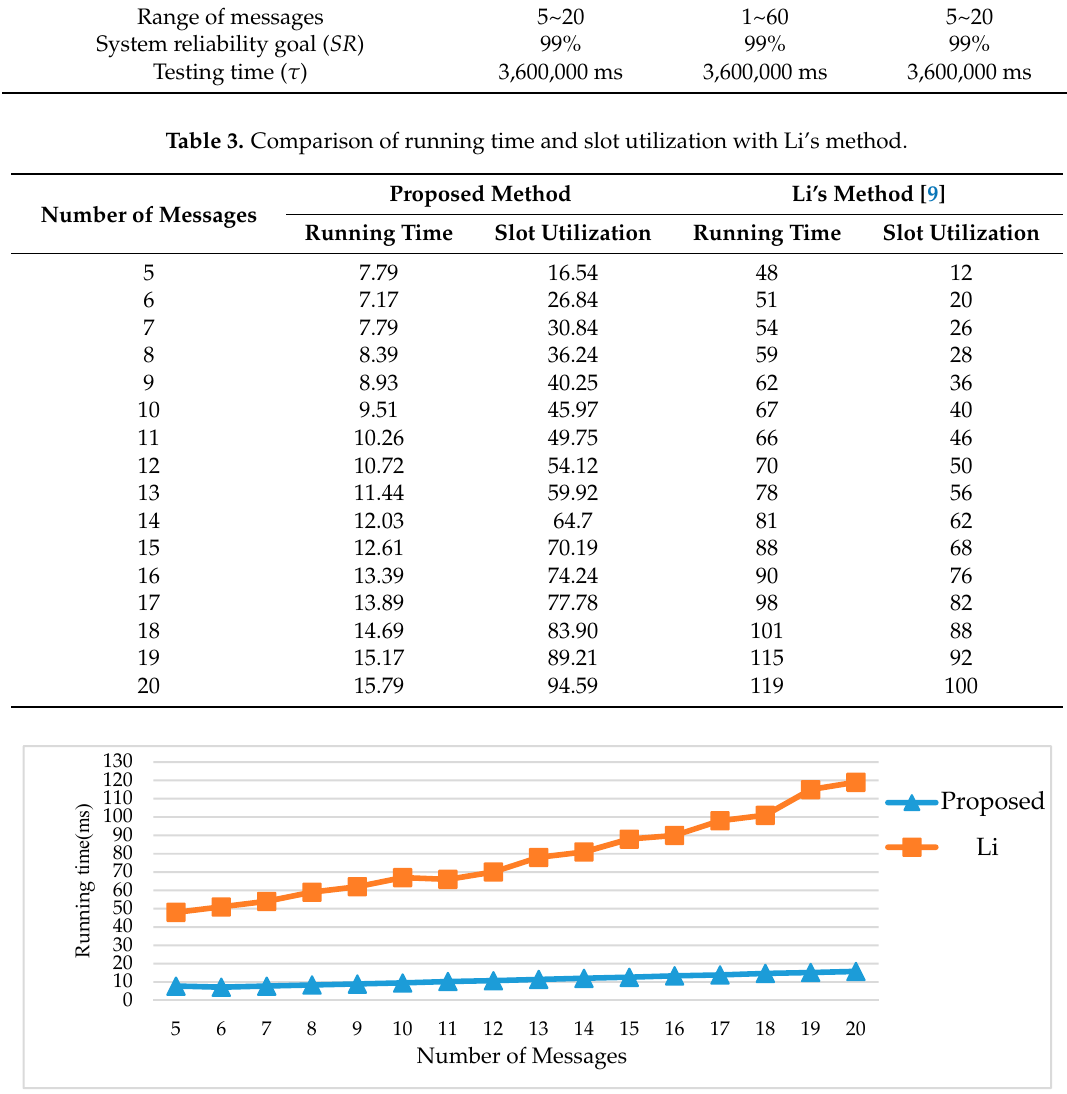
Figure 4. Comparison of running time with Li’s